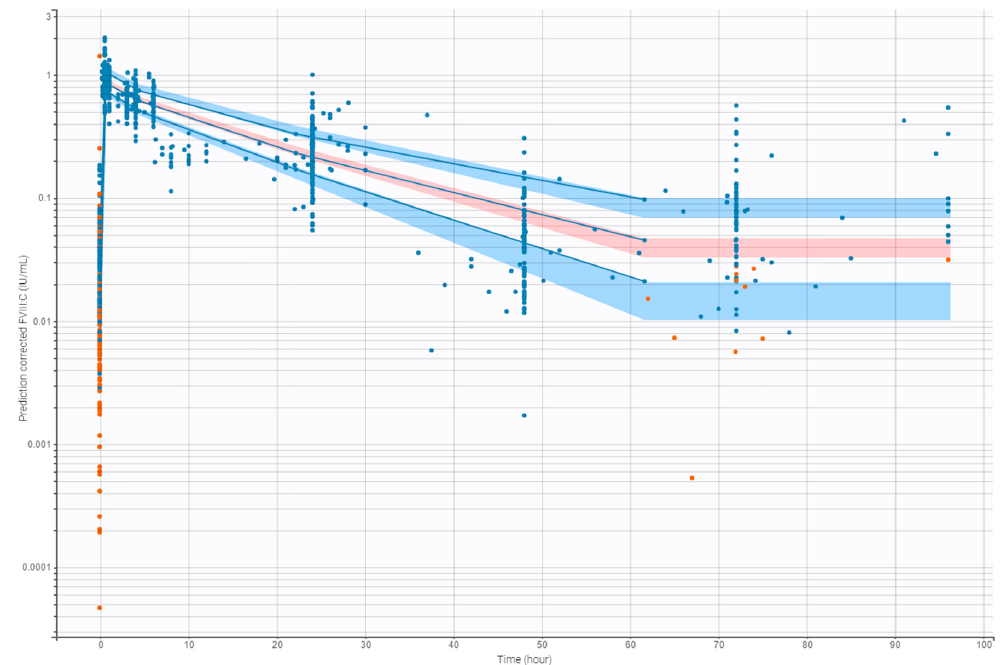
Figure 3. Prediction-corrected visual predictive check (pcVPC) for FVIII:C (IU / mL). Blue dots are observed FVIII:C (IU / mL); orange dots are observed FVIII:C BLQ; blue solid lines represent the median, 10th and 90th percentile of the observed values and shaded areas represent the spread of 90% prediction intervals calculated from simulations.